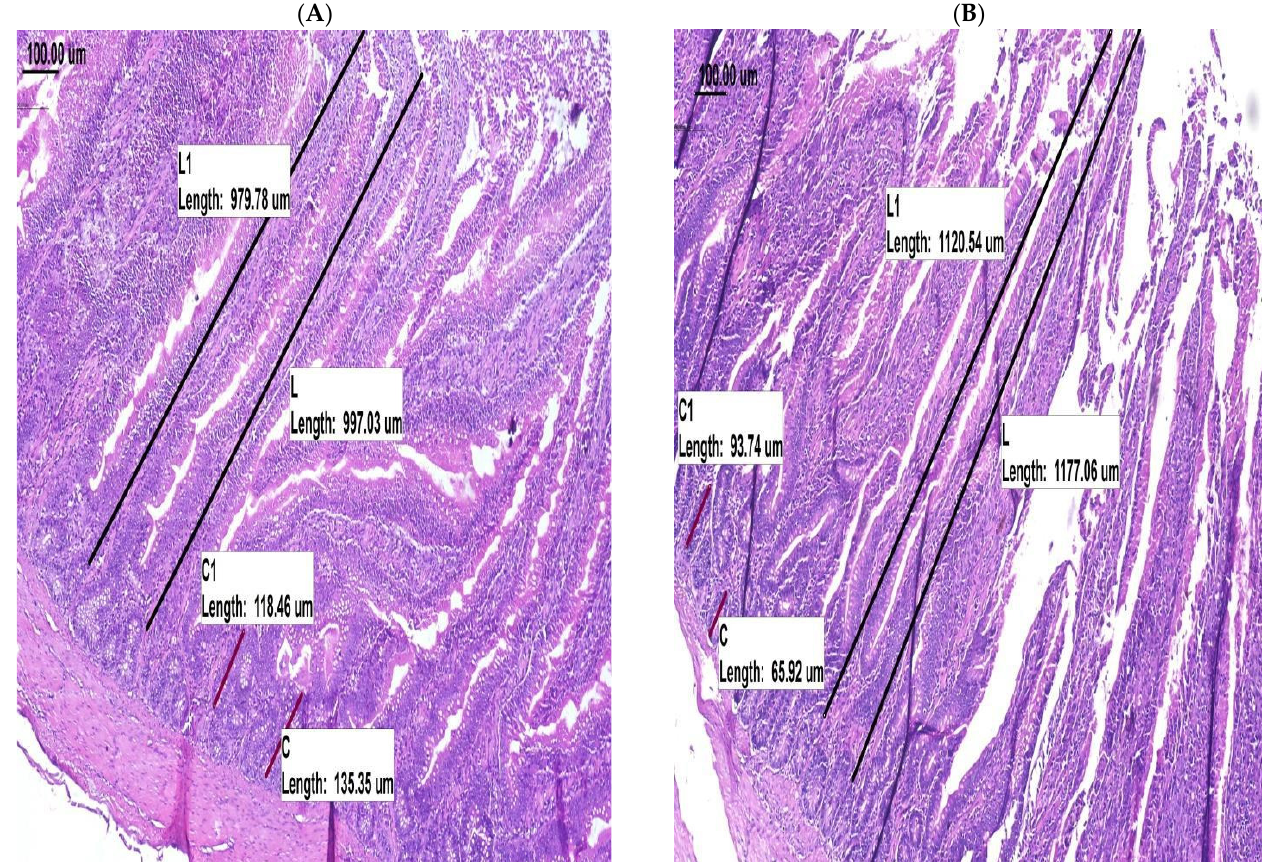
Figure 1. Morphological effects of LEX supplementation on broiler chicken jejunum. Treatments: ( A ) control, ( B ) LEX. ‘L’ and ‘C’ on the slides denote villus and crypt measurements, respectively; two measurements of each were taken per slide.